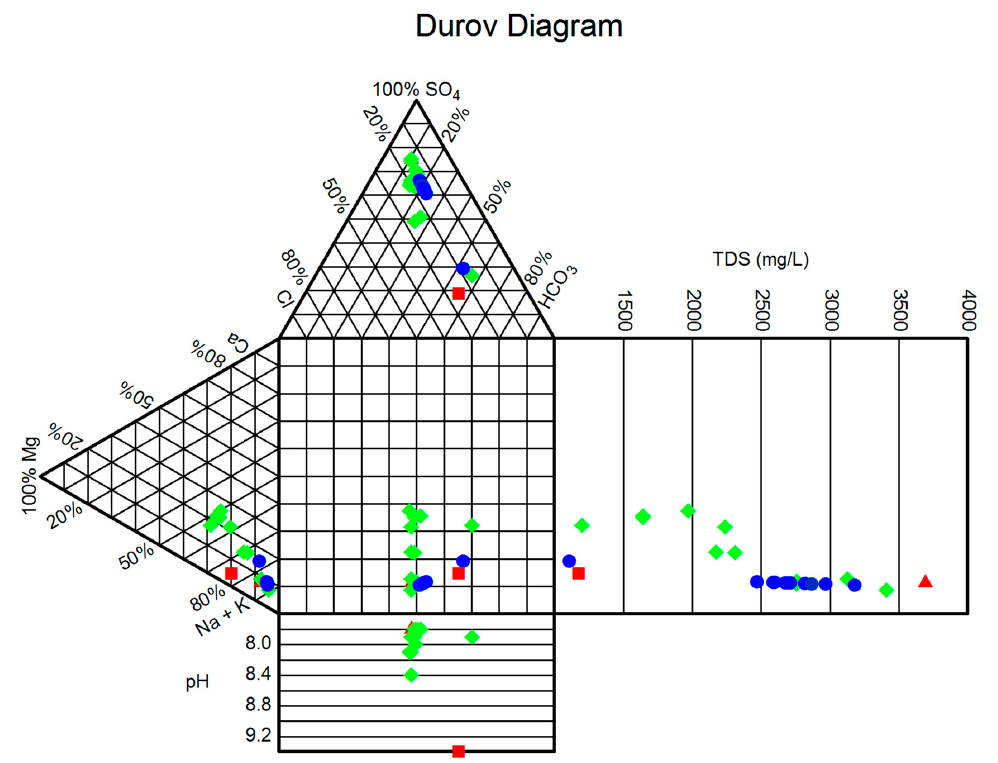
Figure 7. Durov diagram of the hydrochemical type evolution in Carboniferous Taiyuan limestone karst-fissure aquifer systems. The red point shows the background value. The green points show the initial values of all samples. The blue points show the simulated values of all